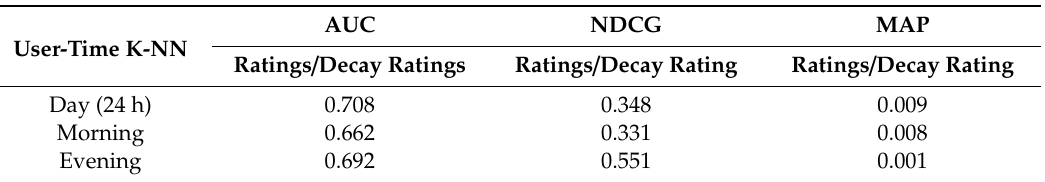
Table 5. The AUC, NDCG and MAP values obtained for top-N recommendation considering the context of time of day.